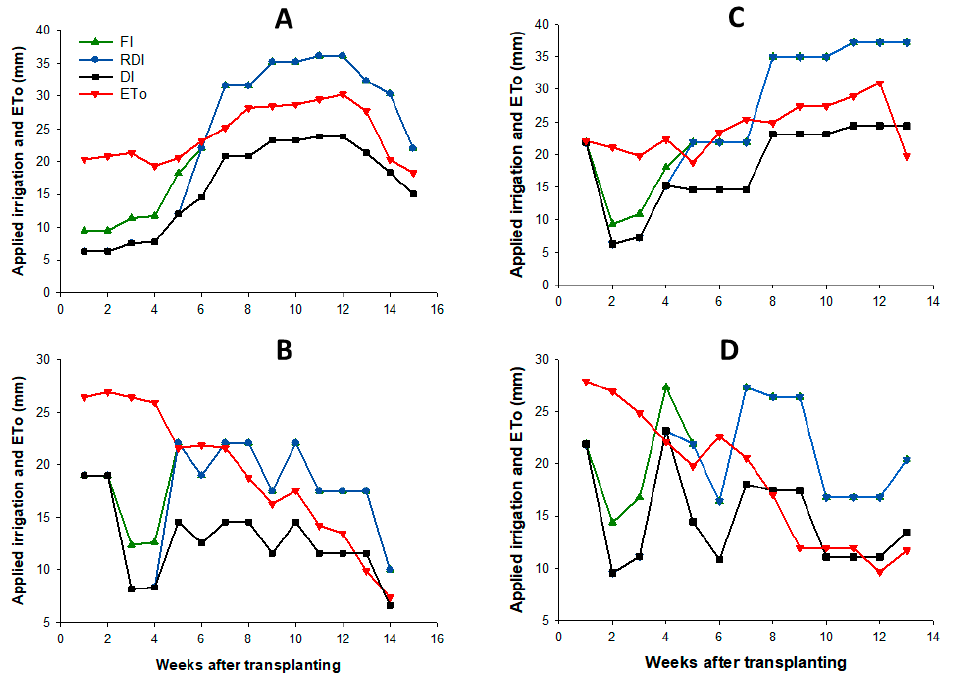
Figure 2. Weekly irrigation water applied and evapotranspiration (ET 0 ) value during spring ( A ) and fall ( B ) seasons of 2018 and spring ( C ) and fall ( D ) seasons of 2019 in Immokalee Florida.